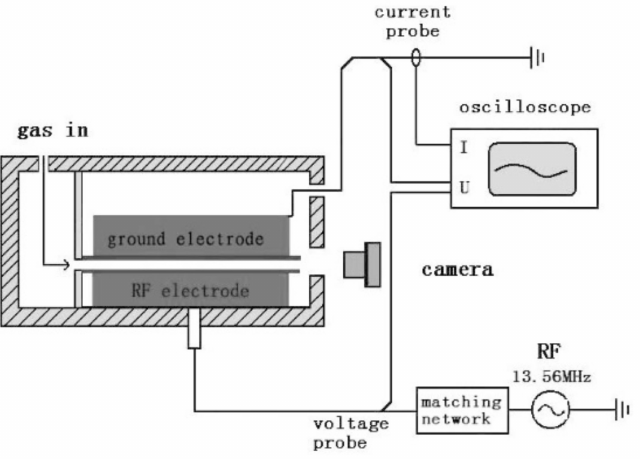
Figure 1. Schematic diagram of experimental